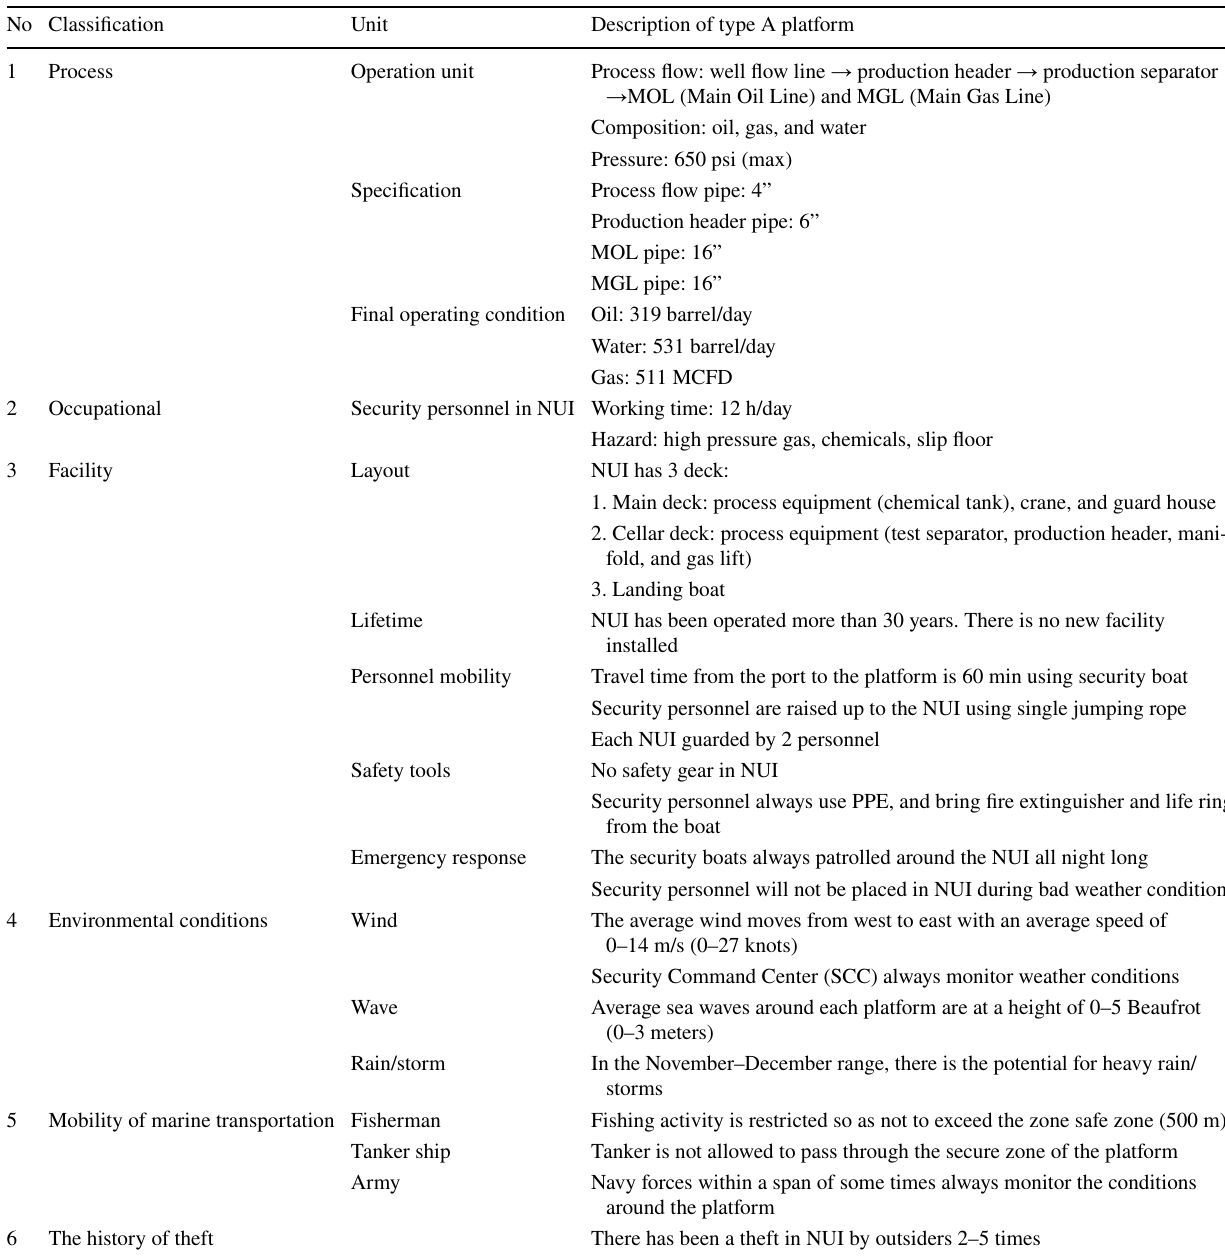
Table 1 Description of type A platform No